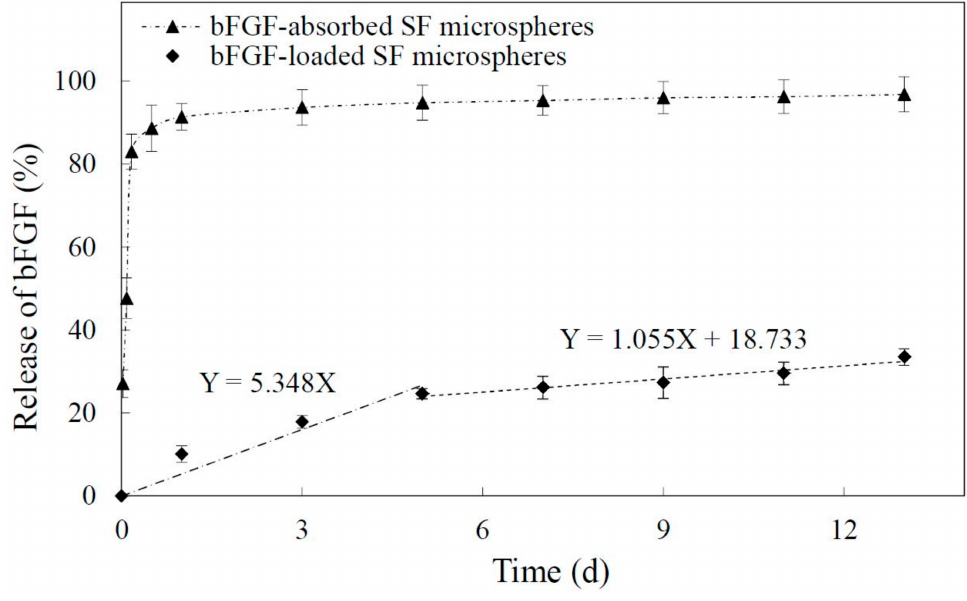
Figure 2. Release of basic fibroblast growth factor (bFGF) from SF microspheres in 13 days. ( ◆ bFGF-loaded SF microspheres showed two release stages; ▲ bFGF-absorbed SF microspheres showed initial burst release).